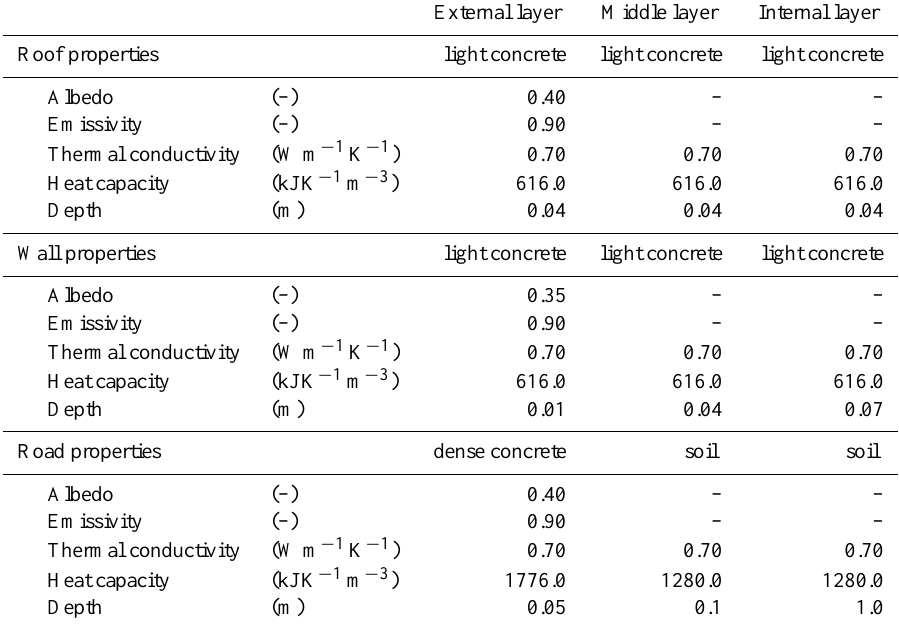
Table 1. TEB’s input parameters relative to radiative and thermal characteristics of impervious covers (Source: Shashua-Bar et al., 2009,